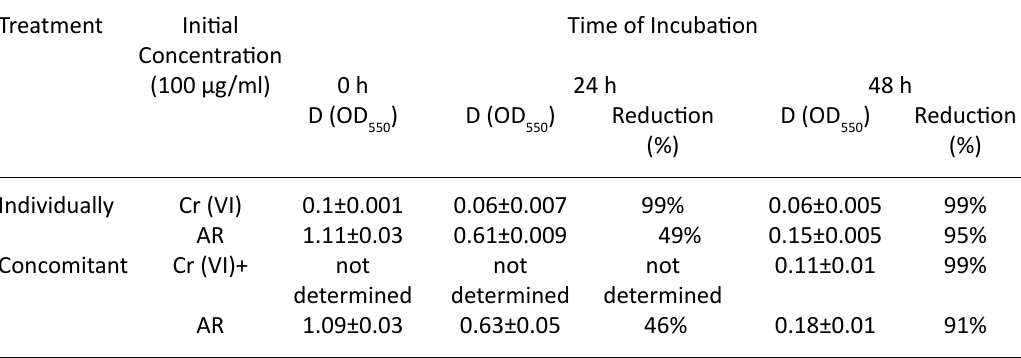
Table 2. Concomitant AR decolorization and Cr(VI) reduction by K. pneumoniae SK1 cultured in microaerophilic condition within 48 h of